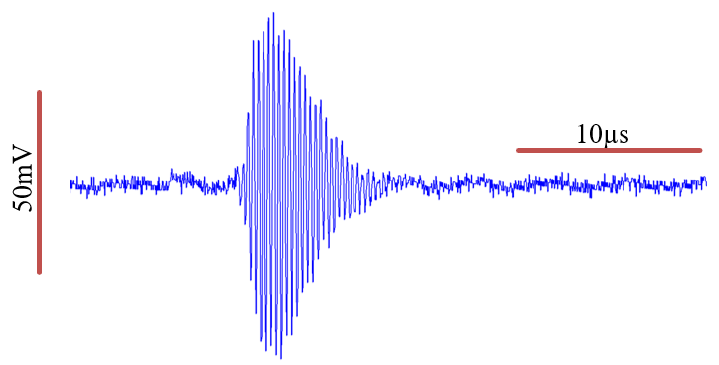
Figure 3. Transmitter element characterization of the acoustic pressure wave in a water tank. An estimated Gaussian envelope of the wave can be identified.